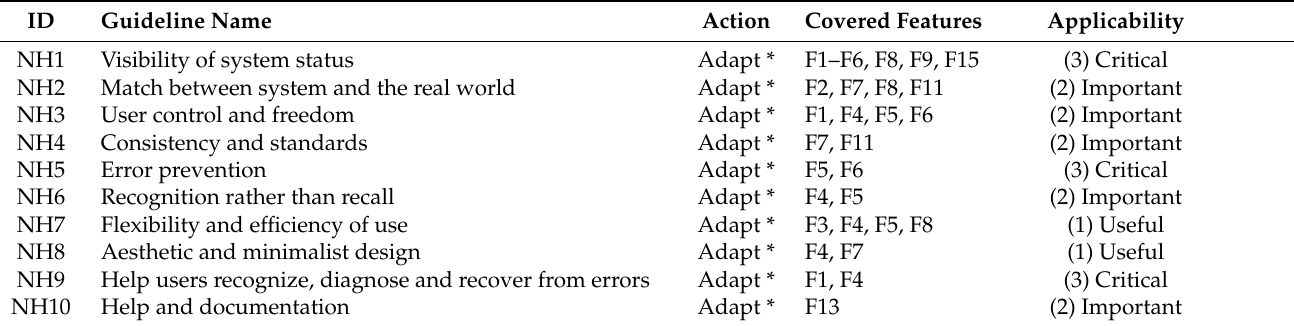
Table 4. Guideline selection process (Nielsen) [11].